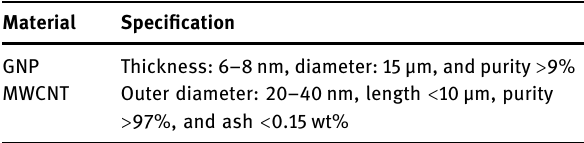
Table 1: Material speci fi cation of GNP and MWCNT nano fi llers